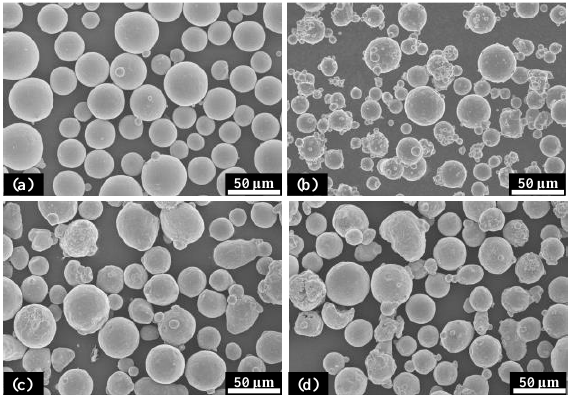
Figure 1. SEM images of four powder particles: ( a ) Ti6Al4V, ( b ) AlSi10Mg, ( c ) 316L and ( d ) IN718.